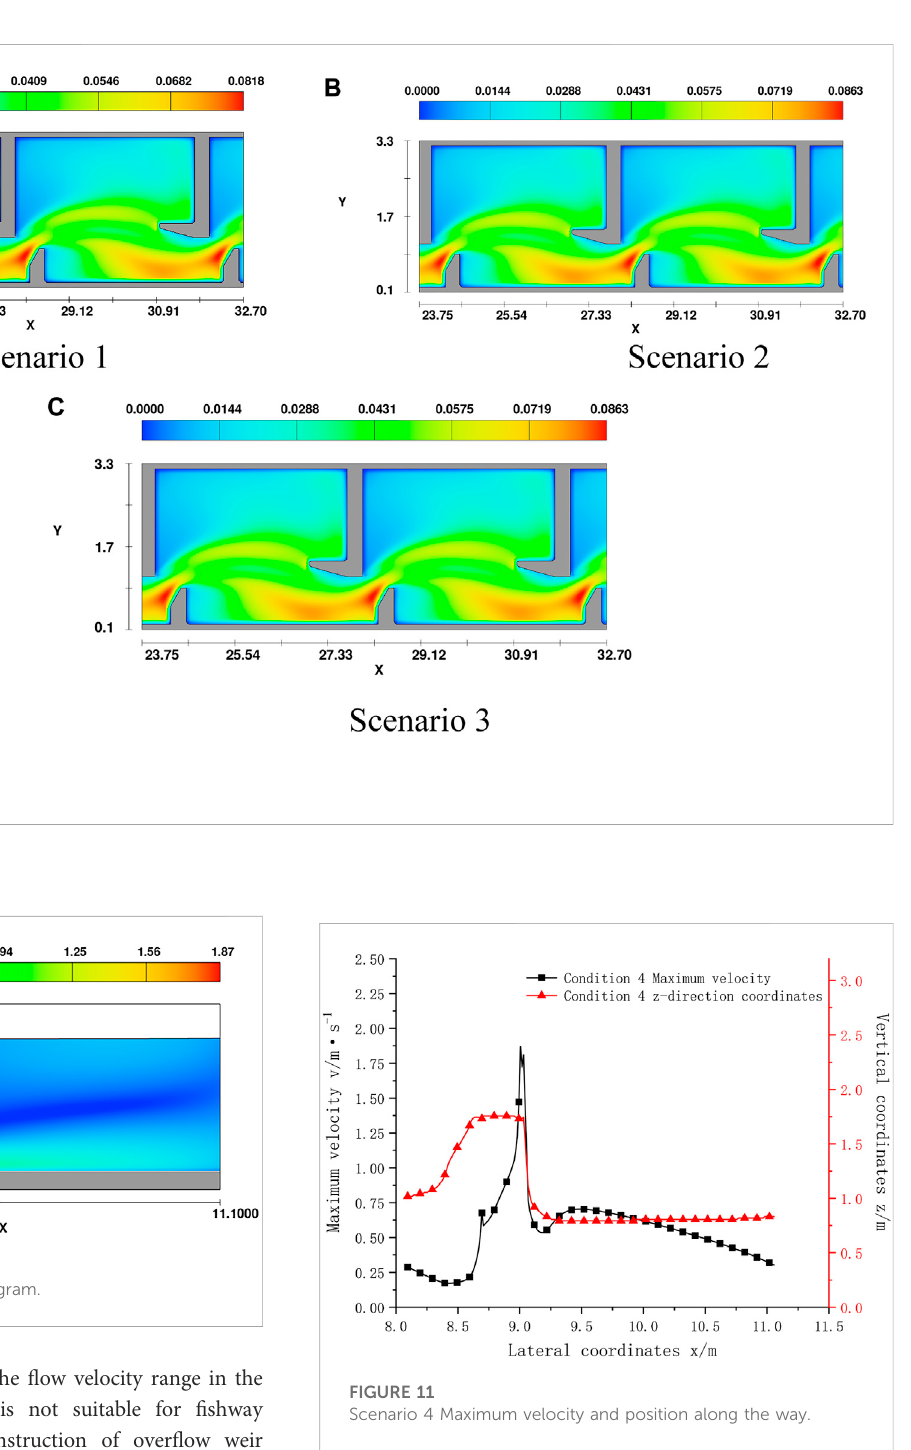
Figure 12A is the turbulent kinetic energy distribution cloud diagram of the middle section of A typical cell at scenario 4. Figure 12B is the turbulent kinetic energy distribution cloud diagram of the middle section of a typical cell at scenario 5. Figure 12C is the turbulent kinetic energy distribution cloud diagram of the middle section of a typical cell at scenario 6. The